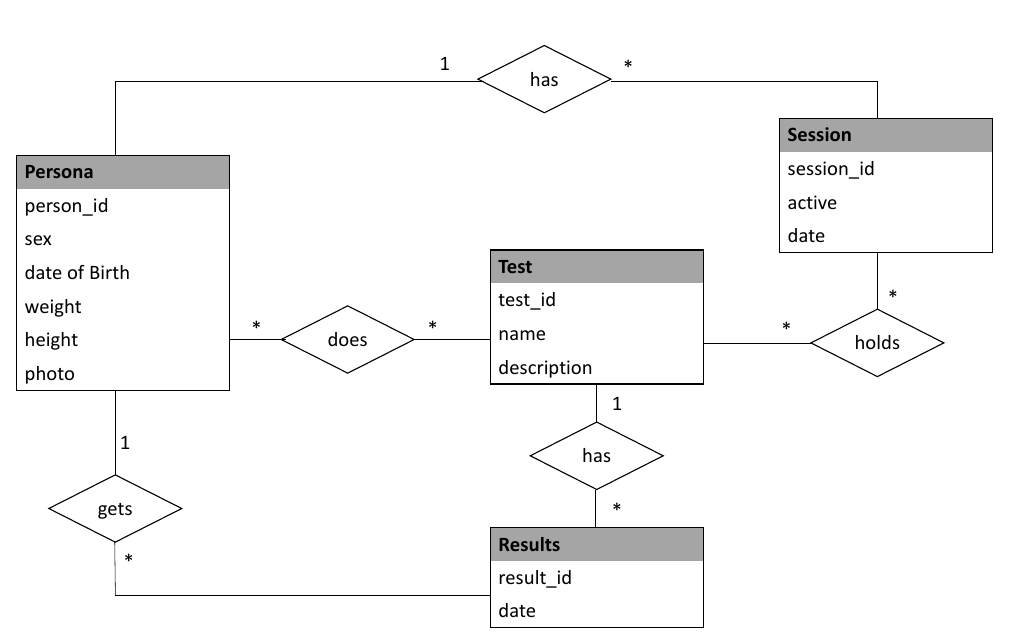
Figure 2. Diagram–entity relationship for the